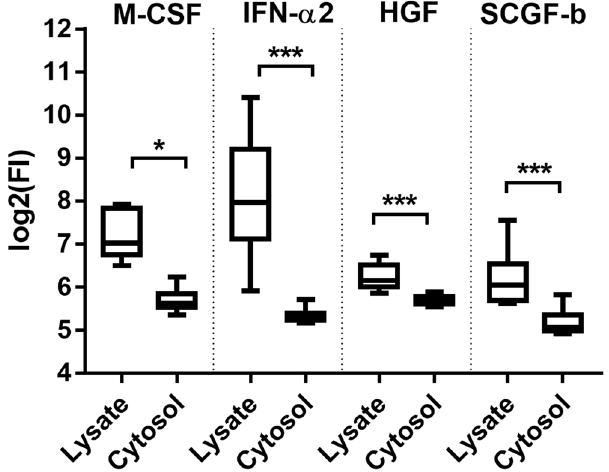
Figure 1. Cytokines in RBC lysate and cytosol. Level of cytokines in the total lysate or cytosolic fraction of RBCs as measured by Bio-Plex and reported as fluorescence. Data are presented as mean with minimum and maximum values ( n = 10). Data are significant if p < 0.05 ( * ), p < 0.01 ( ** ), or p < 0.001 ( *** ).